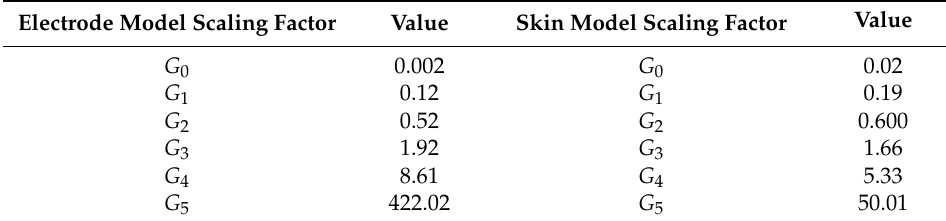
Table 10. Values of the scaling factors G j .